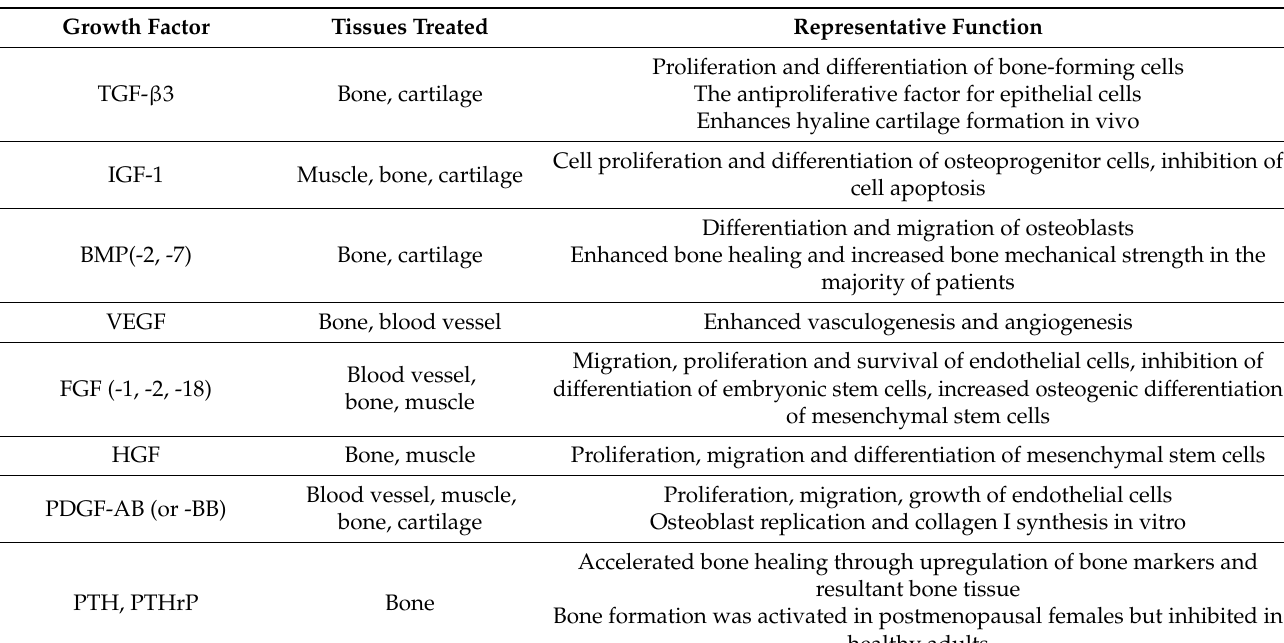
Table 3. A summary of growth factors in tissue regeneration. Adapted with permission from Reference [37]. Growth Factor Tissues Treated Representative Function Proliferation and differentiation of bone-forming TGF- β 3 Bone, cartilage